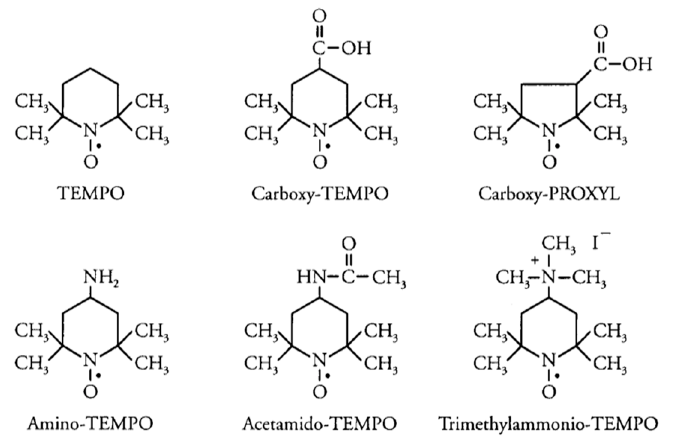
Figure 2. Porous poly(styrene-co-divinylbenzene) monoliths with controlled pore size distribution